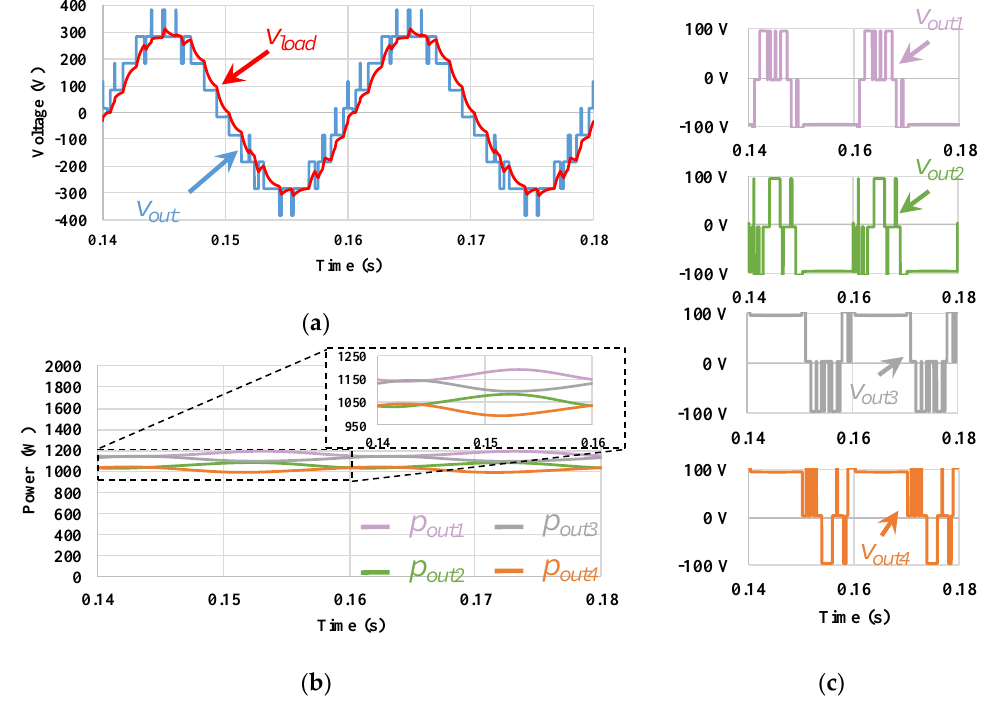
Figure 16. Simulation results of the balanced PD PWM technique: ( a ) output voltage of the cascaded MLC, v out , and load voltage, v load ; ( b ) output power on each submodule ( p out1 , p out2 , p out3 , p out4 ); ( c ) output voltage on each submodule ( v out1 , v out2 , v out3 , v out4 ).